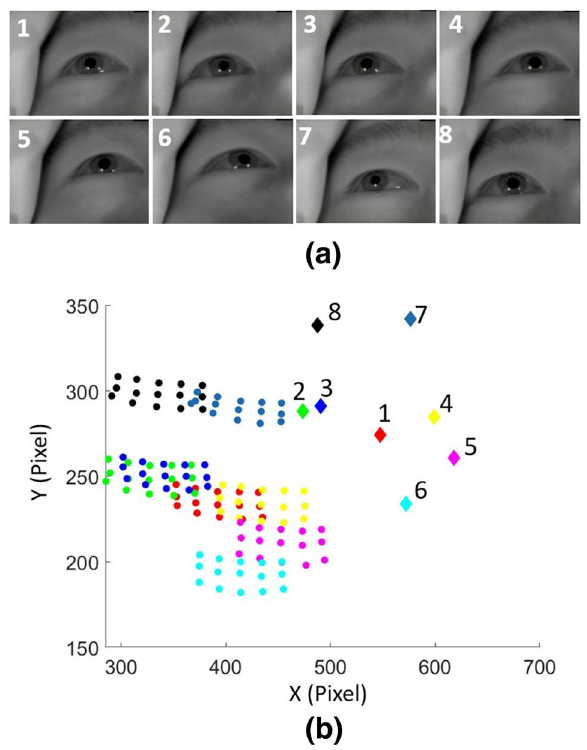
Figure 7. Effect of head movement on detected pupil locations when fixating on an unchanging grid of 15 points shown in Fig. 6a: ( a ) Screenshots showing eye positions in each of 8 head poses. ( b ) The pupil positions (solid circles) and eye corner locations (solid diamond) for each of the poses in ( a ). Each color group (15 pupil points and 1 median corner point) are the measured pixel values for correspondingly numbered pose. The input eye image is 640 × 480 pixels. Calibration is based on the first